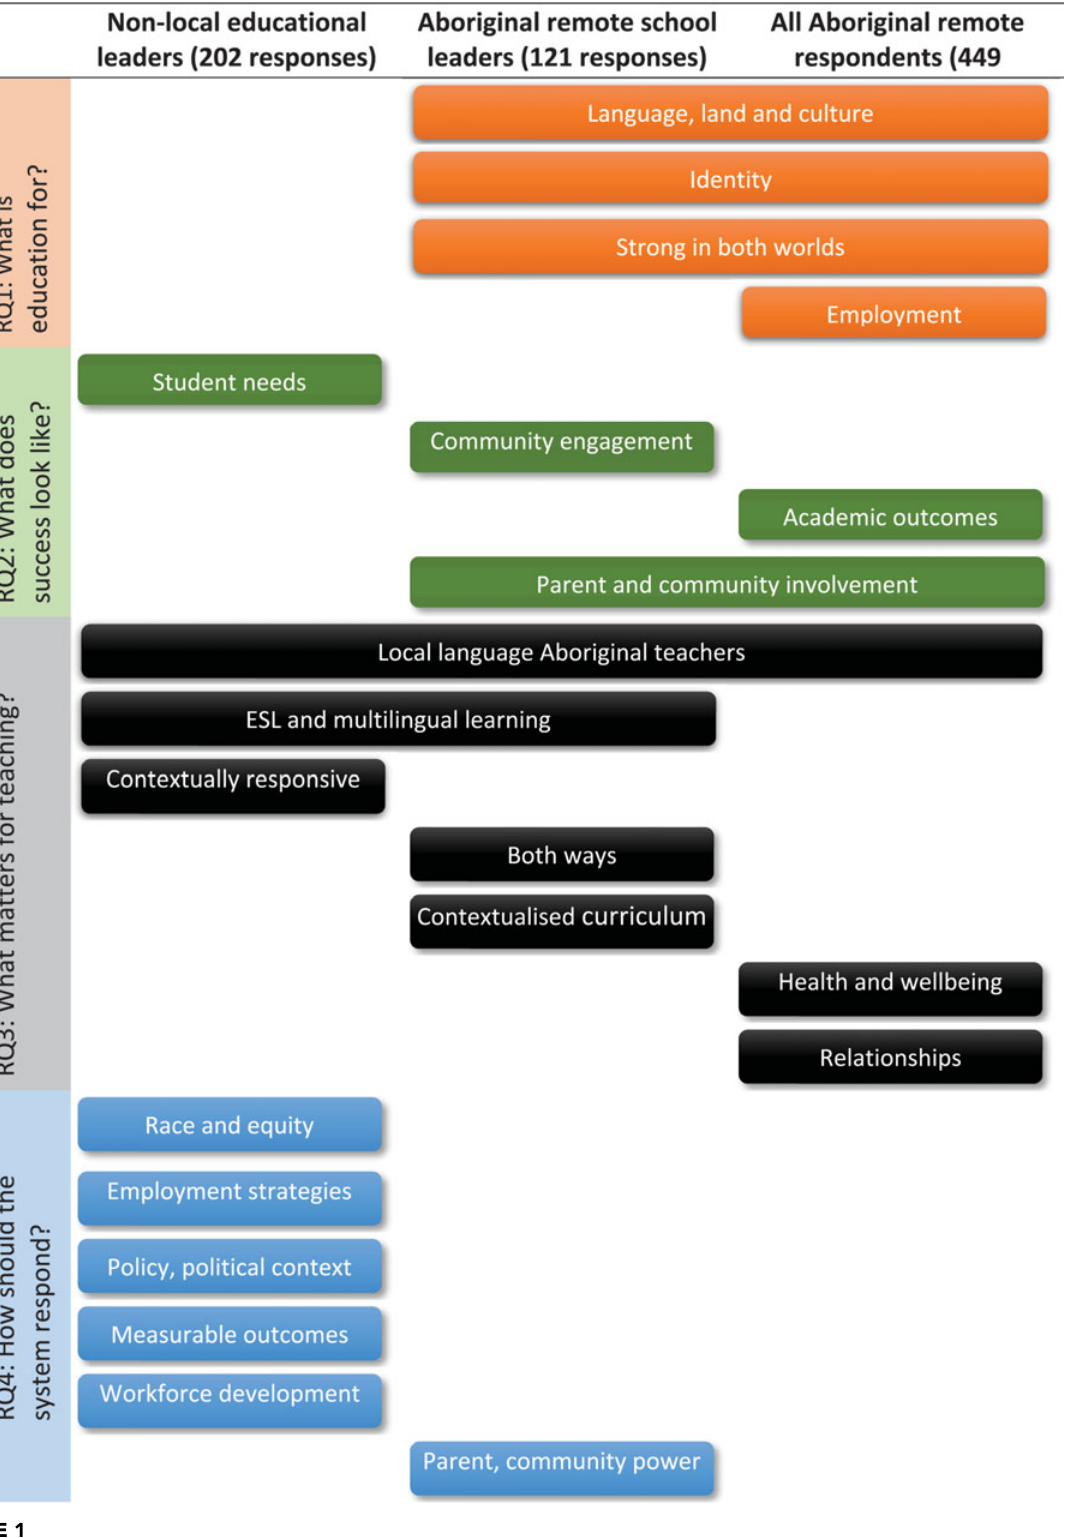
FIGURE 1 (Colour online) Main issues raised for each RQ by respondent